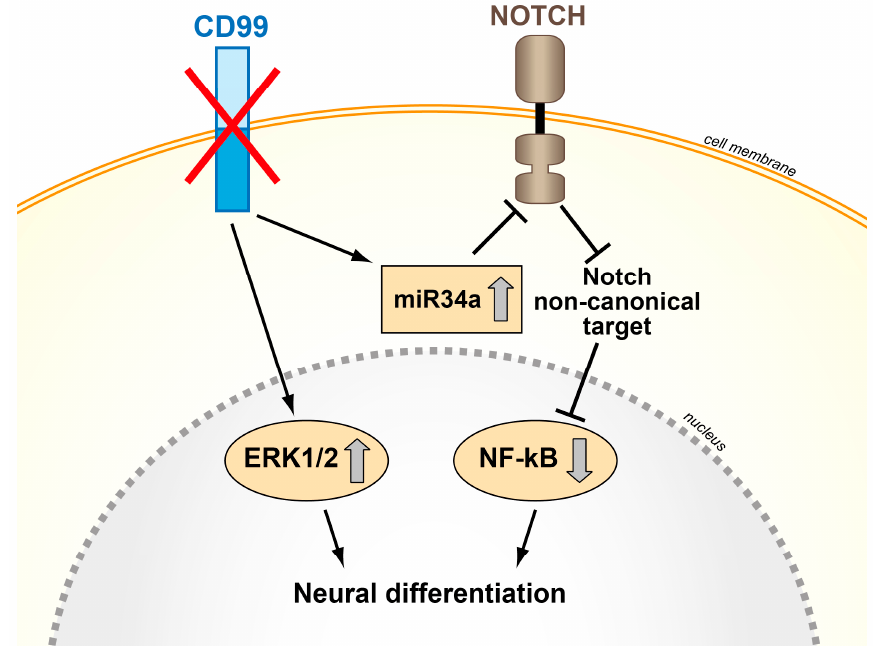
Figure 4. Schematic representation of the effects of CD99 silencing in Ewing sarcoma cells. The abrogation of CD99 induces Ewing sarcoma neural differentiation through nuclear ERK1/2 stabilization and miR34a upregulation and Notch-NF-kB inhibition [59,74].